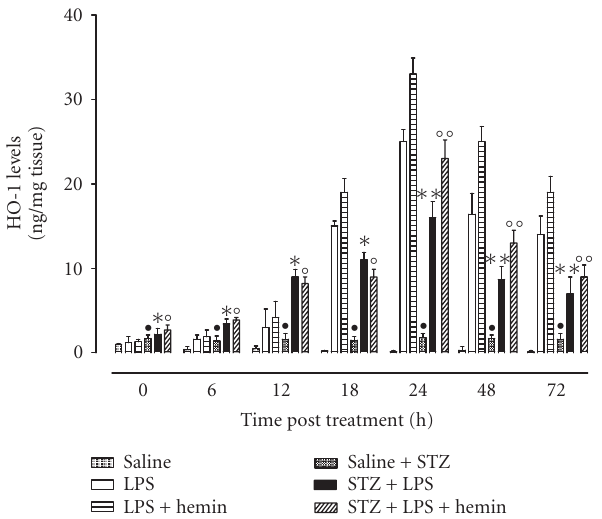
Figure 2: Myeloperoxidase activity (MPO) in ciliary body. Rats treated as described in Figure 1 had ciliary body collected at the end of the 24h endotoxin-induced uveitis and MPO activity deter- mined. Values are mean ± SEM of n = 6 rats per group. Signifi- cance is expressed as • P < . 05 versus vehicle saline nondiabetic rats; ∗ P < . 05 and ∗∗ P < . 01 versus LPS nondiabetic rats; ◦ P < . 05 and ◦◦ P < . 01 versus LPS+hemin nondiabetic